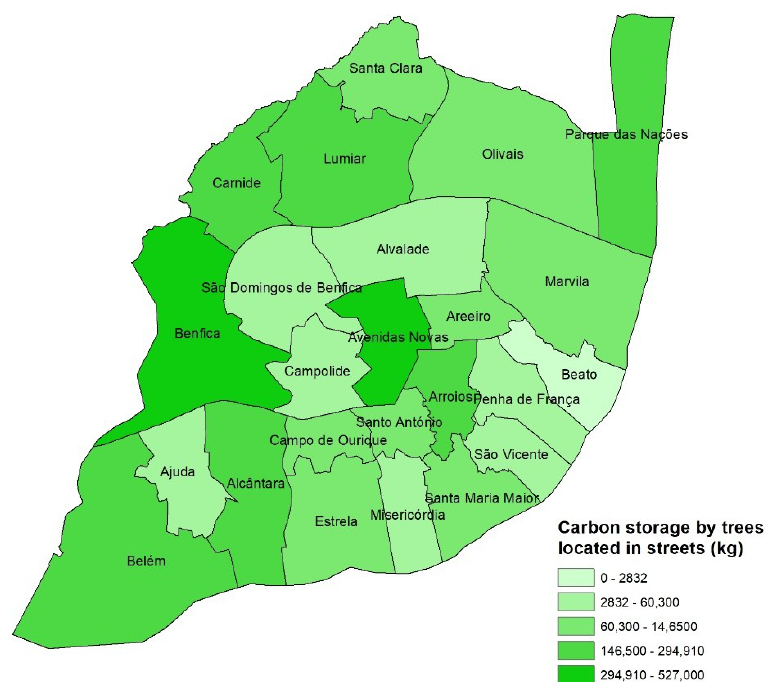
Figure 11. Carbon storage by trees located in streets for each parish of the city of